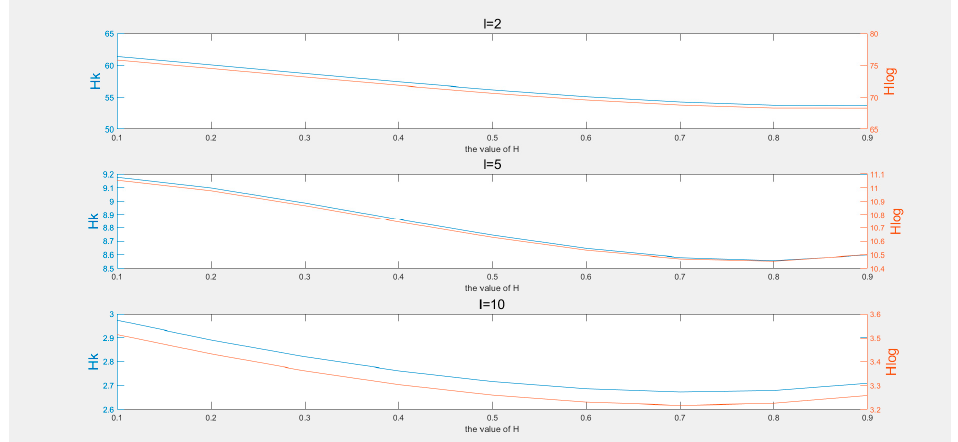
Figure 1. Comparison of asymptotic variance of H k and H log .